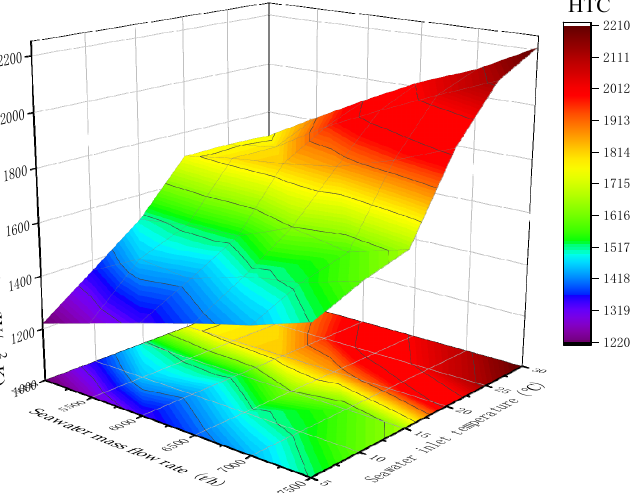
Figure 7. The overall heat transfer coefficient of the propane vaporizer at different seawater flow rates and seawater inlet temperatures. As can be seen from Figure 7, the overall heat transfer coefficient increased with the increase in seawater mass flow rate and seawater temperature in E1. As the seawater temperature increased, the increasing rate of the overall heat transfer coefficient increased. Furthermore, the larger the seawater mass flow rate was, the greater the effect of the